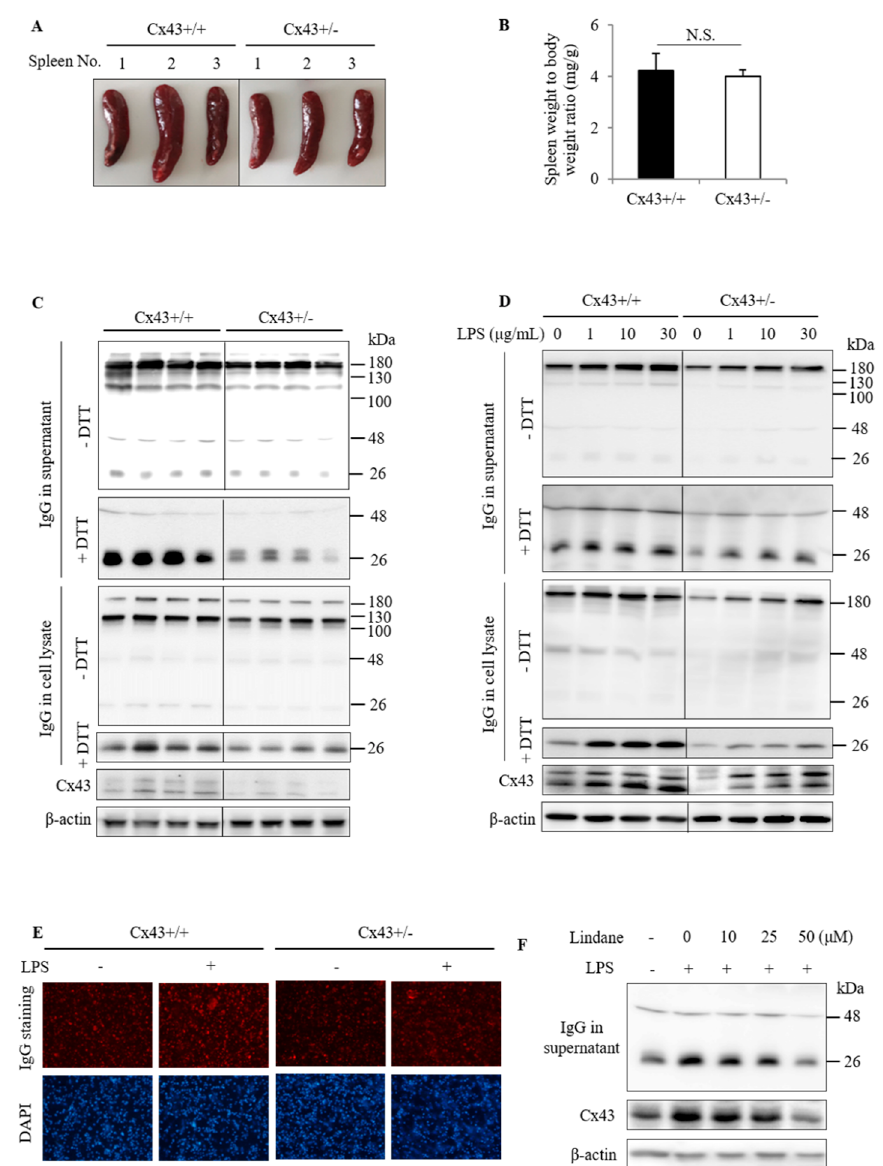
these observations indicate that Cx43 regulates IgG production by isolated spleen cells.